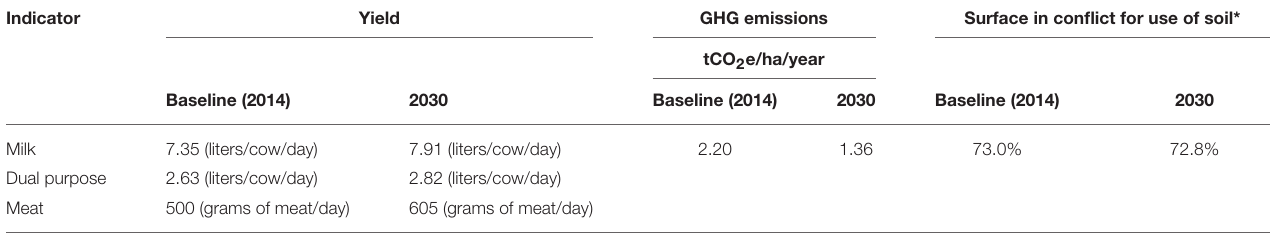
TABLE 1 | Green Growth indicators for the livestock sector in Colombia, 2014–2030.